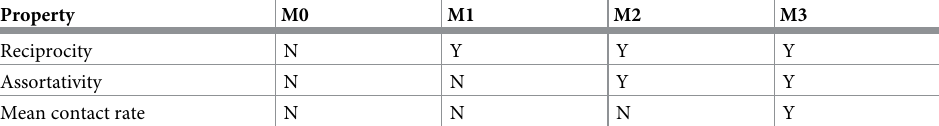
Table 1. Contact matrix transformation methods. The properties preserved by each transformation M0–M3 are indicated as Yes (Y)/No (N) in the table. Adapted from Arregui et al [10]. Property M0 M1 M2